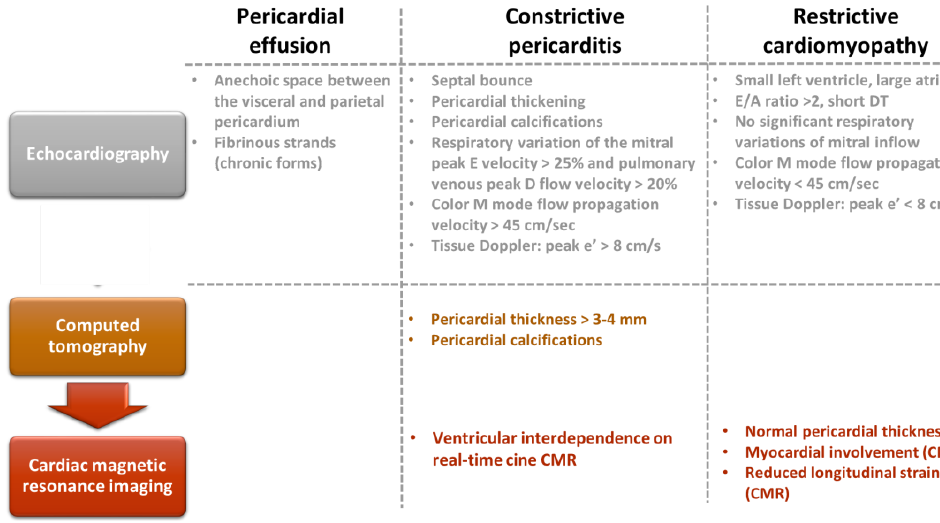
Figure 4. Multimodal imaging evaluation of patients with pericardial effusion, constrictive pericarditis, and restrictive cardiomyopathy (adapted after [114]).